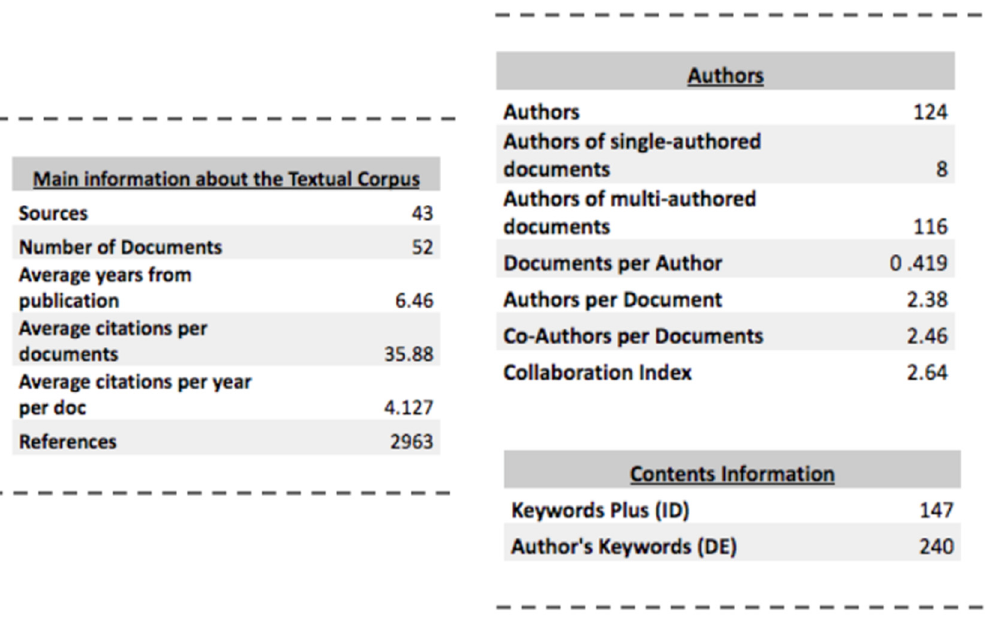
Figure 5. Bibliometric